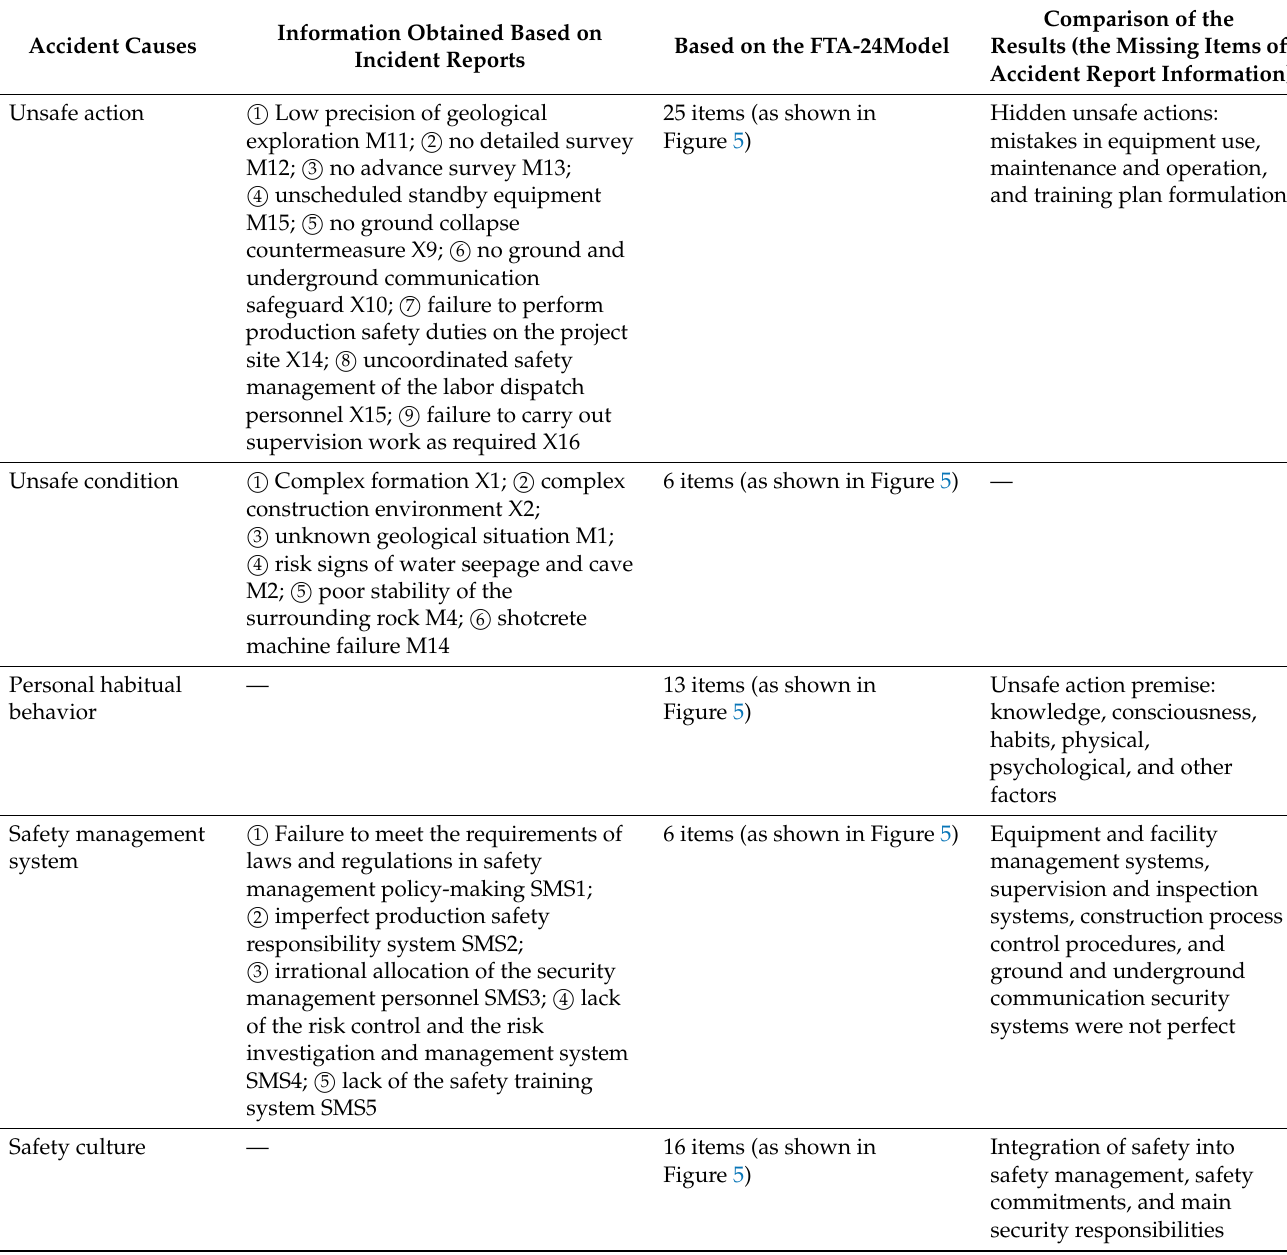
Table 3. Comparison of the accident cause analysis results obtained by different analysis